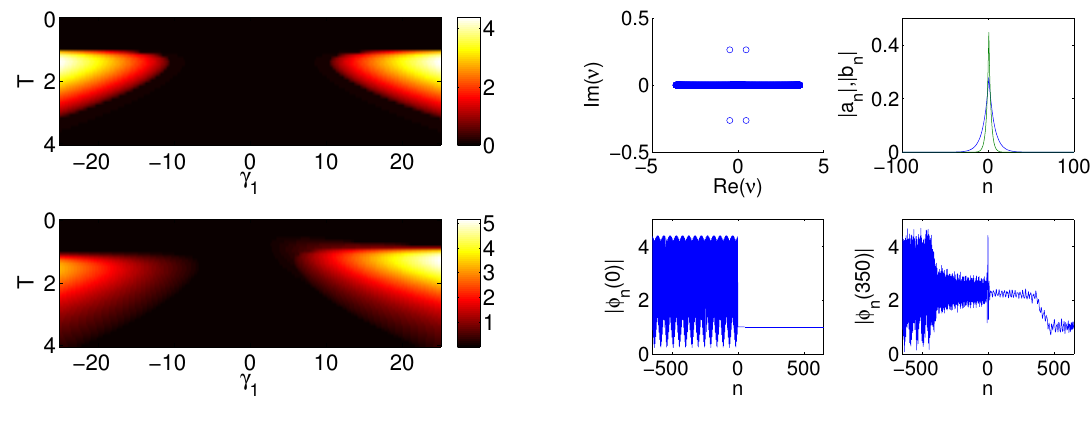
Figure 3. The plots are similar to the left panel in Figure 2. Here the left panel corresponds to N = 2 , L = 100 and we plot | min( Im ( ν ) | as a function of γ γ = 1 in the top graph and γ = − 1 in the bottom graph. Here the right panel is fixed: γ 1 1 1 corresponds to N = 3 , L = 101 and we plot | min(Im( ν ) | as a function of γ = 1 , γ = 5 in the top graph and γ the values of γ and γ are fixed: γ 1 3 1 3 bottom